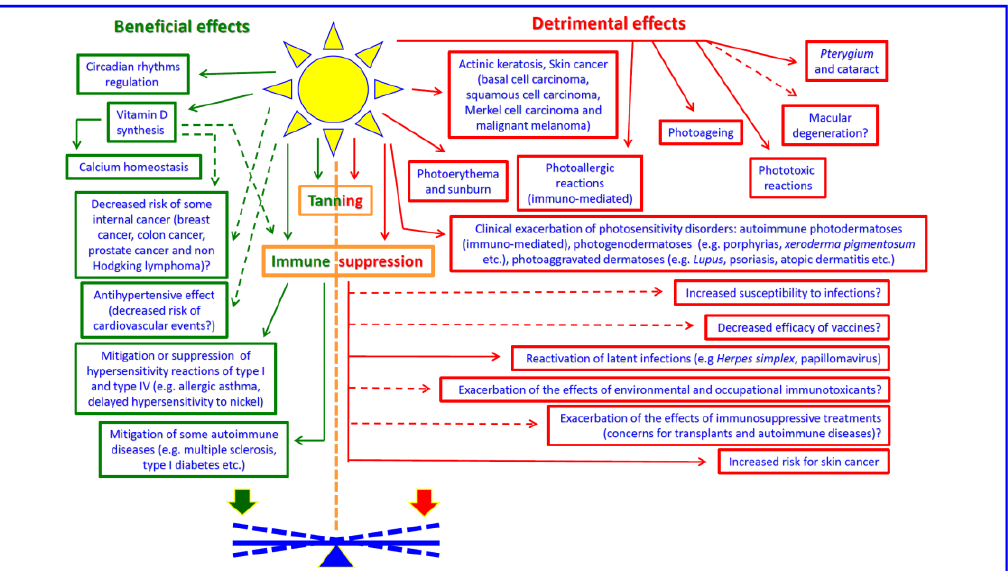
Figure 1. An overview of the health effects due to SR (Solar Radiation). Question marks and dashed arrows indicate effects not yet established or not yet fully established. Most of SR health effects are induced by UVB (UltraViolet B) and UVA (UltraViolet A), but for other ones visible radiation may be directly involved (e.g., circadian regulation, a subset of phototoxic and photoallergic reactions and macular degeneration). The balance between potential beneficial and detrimental effects in a given situation of exposure and for a given individual is often very difficult to address.